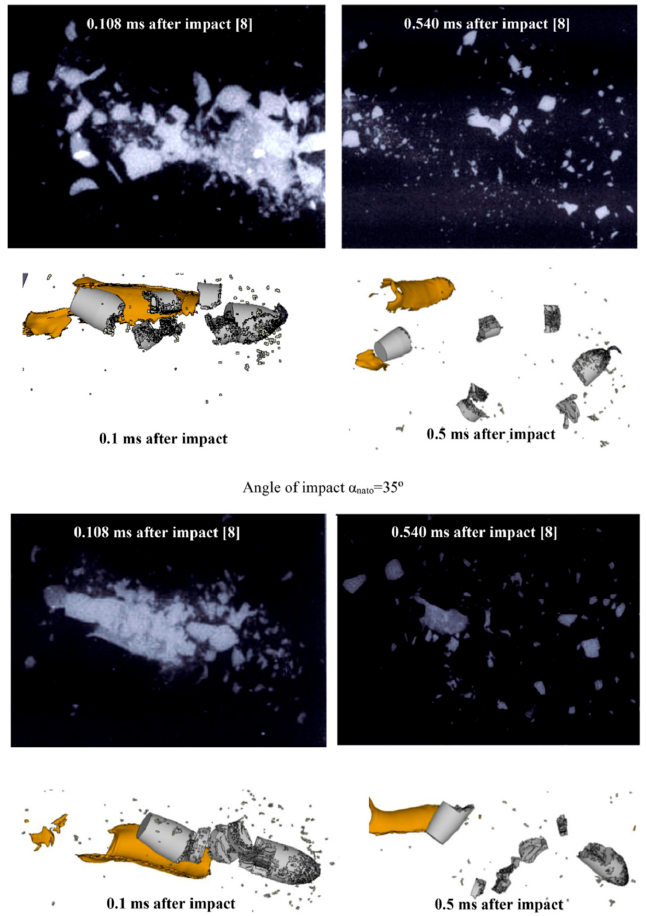
Figure 15. Comparison of the projectile fragmentation obtained experimentally and in the simulations with the use of principal stress/strain failure criterion applied for the hardened steel cores